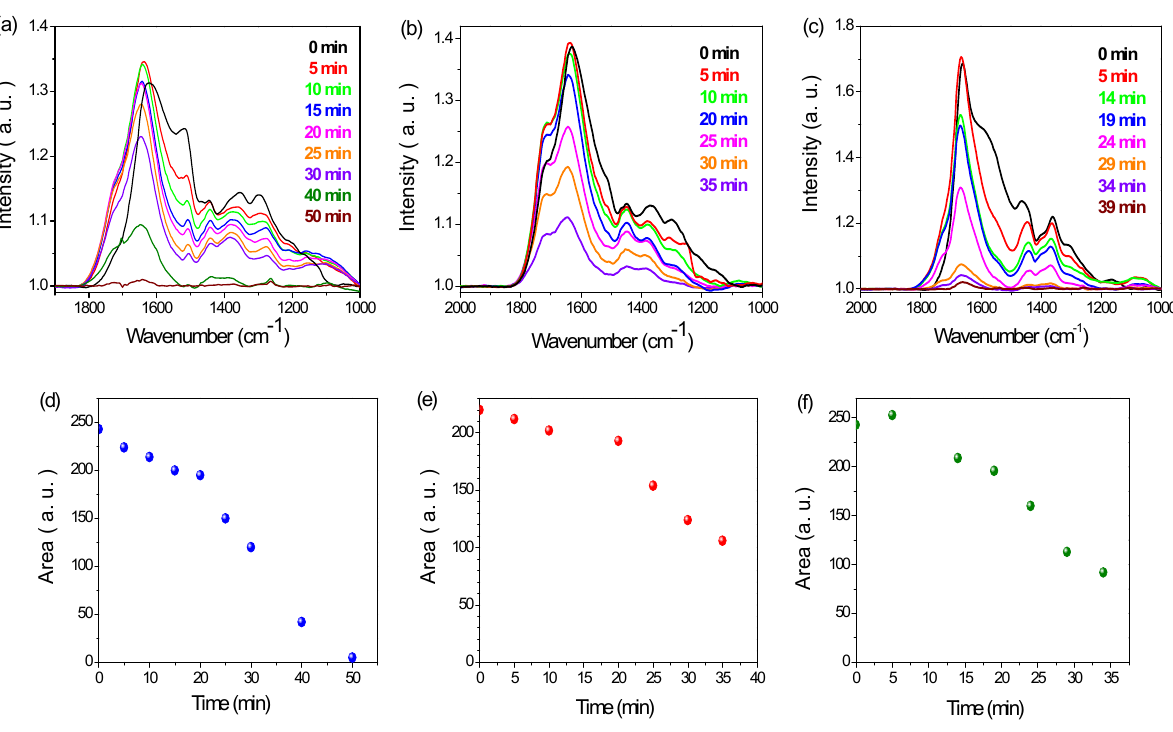
Figure 4. Chlorination of PDA films as a function of immersion time in ( a , b ) 1 mM, ( c ) 10 mM NaOCl solution. ( a – c ): PM-RAIRS spectra. ( d – f ): area under IR peaks. ( a , d ): PDA–O 2 ; ( b , e ): PDA–IO 4 − ; ( c , f ): PDA–PEI.